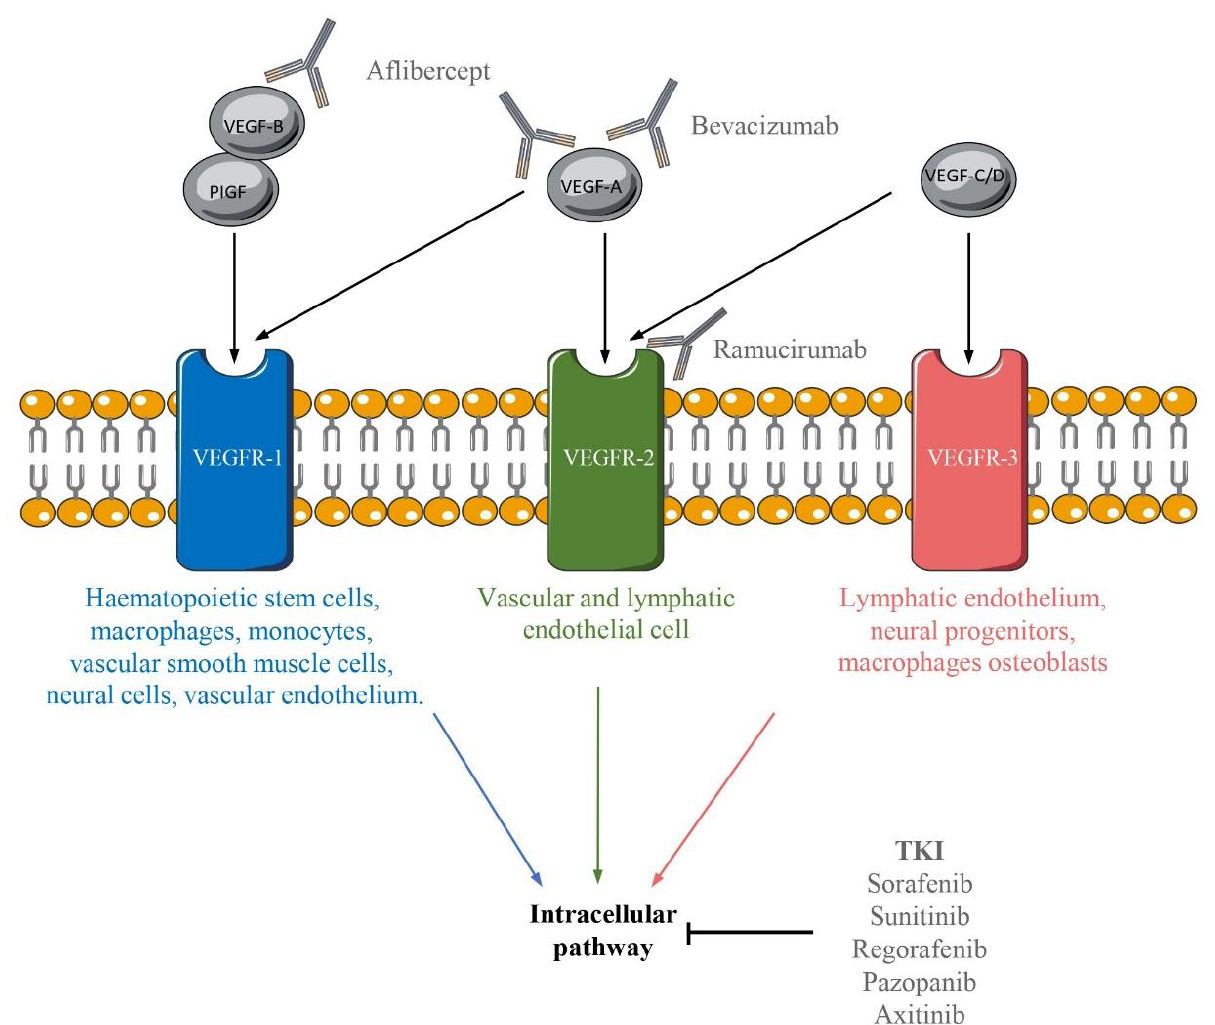
Figure 1. Representation of the different bindings between VEGF/VEGFR and the molecules inhibiting their signaling pathways. The mammalian VEGF family is composed of five members: PIGF, VEGF-A, VEGF-B, VEGF-C and VEGF-D. These different members bind VEGFR: VEGFR-1, VEGFR-2, and VEGFR-3. These receptors are present on the surface of various cells indicated under the receptor. Various inhibitors can target the VEGF/VEGFR signaling pathways.